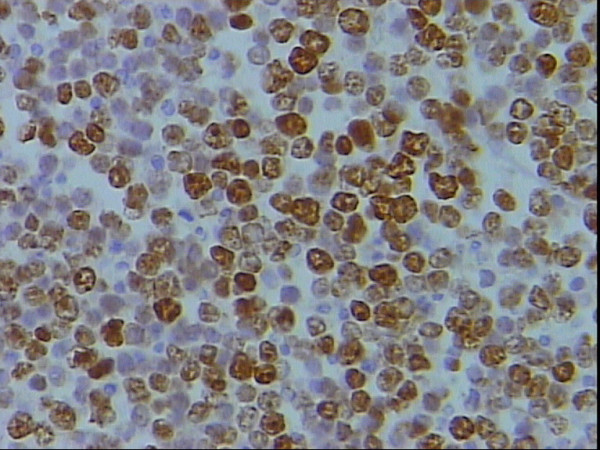
Strong nuclear, nucleolar Mum-1 staining of 50% of the neoplastic lymphocytes, DAB, Hx, × 40.